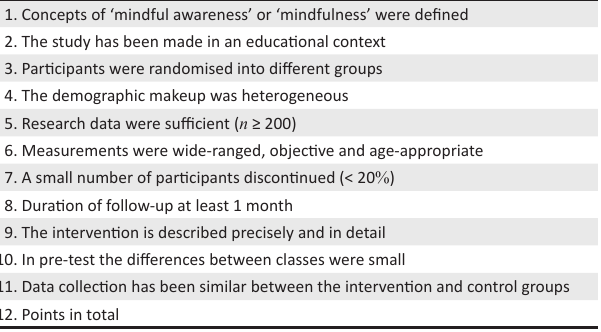
TABLE 3: Criteria of methodological validity of intervention studies.